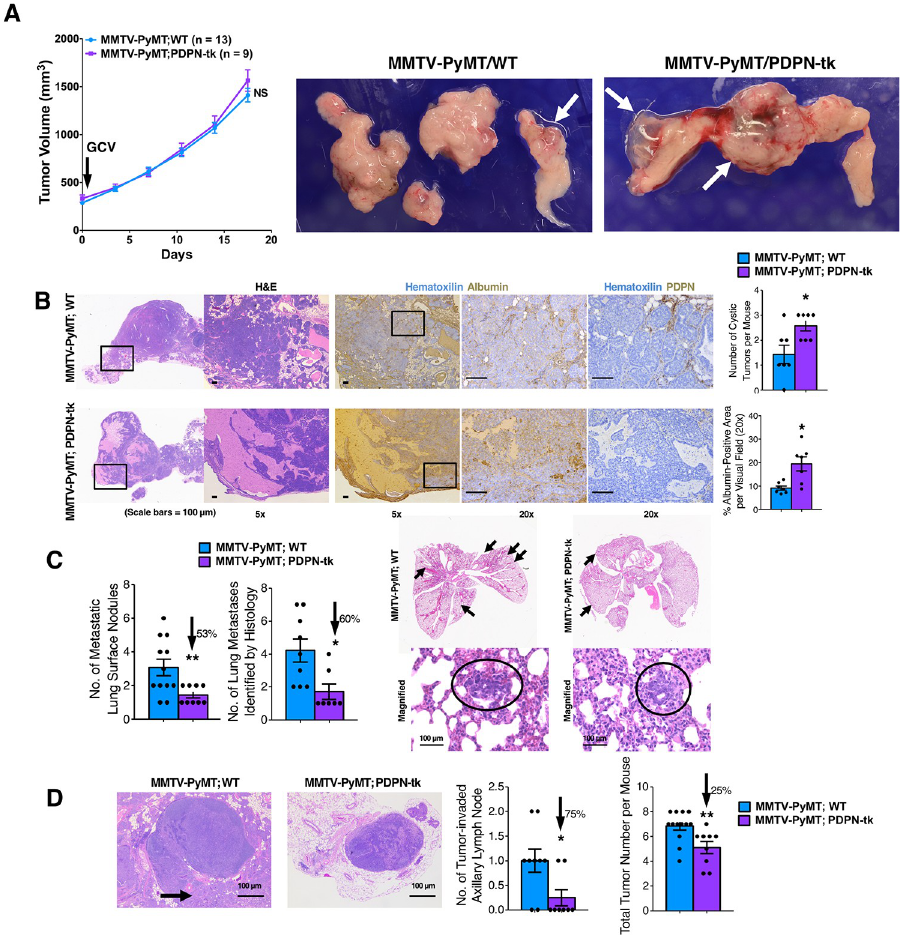
Fig 4. Lung and LN metastasis from MMTV-PyMT mammary tumor is inhibited by suppression of lymphangiogenesis. (A) The growth of spontaneous mammary tumors in GCV-treated MMTV-PyMT; PDPN-tk mice ( n = 9) or MMTV-PyMT; WT female mice ( n = 13). GCV label indicates the starting day of GCV treatment. Cystic tumors are indicated by white arrows in the representative pictures of excised tumors. (B) H&E and IHC (albumin or PDPN) stainings of MMTV-PyMT; PDPN-tk or MMTV-PyMT; WT tumors. Number of cystic tumors per mouse were shown for MMTV-PyMT; PDPN-tk or MMTV-PyMT; WT groups. Albumin accumulation was quantified from IHC staining images for both groups. (C) The evaluation of surface metastatic lung nodules and histologically identified lung metastases in MMTV-PyMT; PDPN-tk mice or MMTV-PyMT; WT mice. (D) The number of tumor-invaded axillary LNs and total number of tumors per mouse in MMTV-PyMT; PDPN-tk mice or MMTV-PyMT; WT mice. Scale bars (C-G), 100 μ m. Data are represented as mean ± SEM. Significance is determined using an unpaired two-tailed Student t test ( � p < 0.05, �� p < 0.01). The underlying data can be found in S1 Data. GCV, ganciclovir; H&E, hematoxylin and eosin; IHC, immunohistochemistry; LN, lymph node MMTV-PyMT, mouse mammary tumor virus–polyoma middle tumor antigen; NS, not significant; PDPN, podoplanin; tk, thymidine kinase; WT, wild